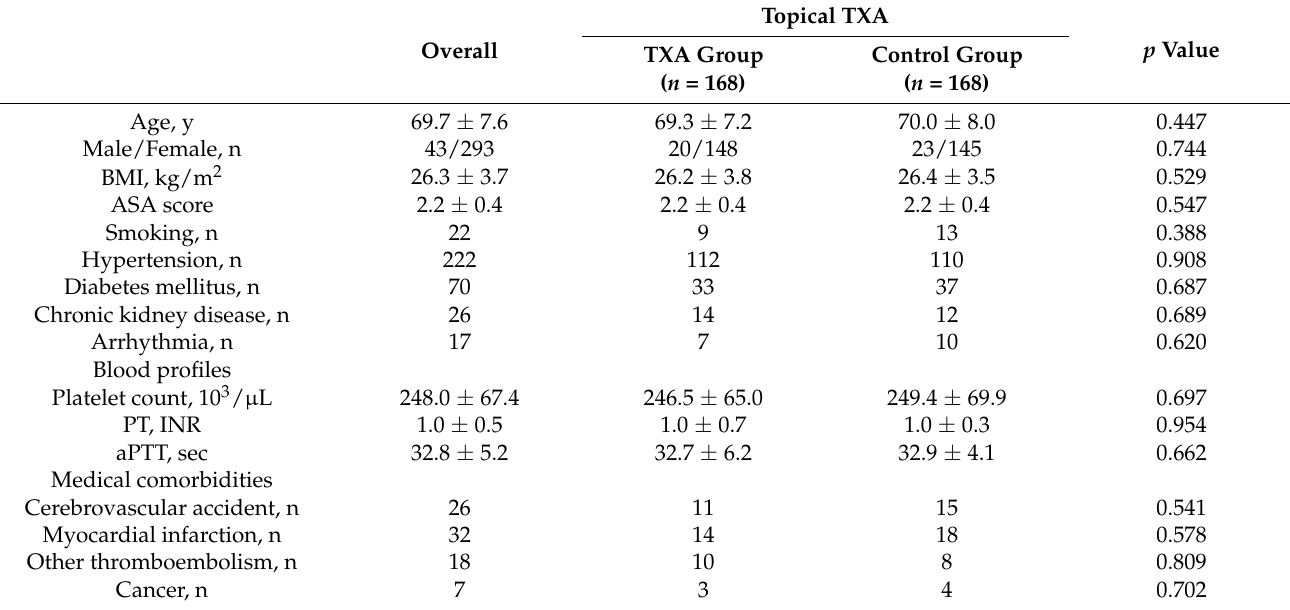
Table 2. Patient characteristics between the TXA and the control groups after PSM.